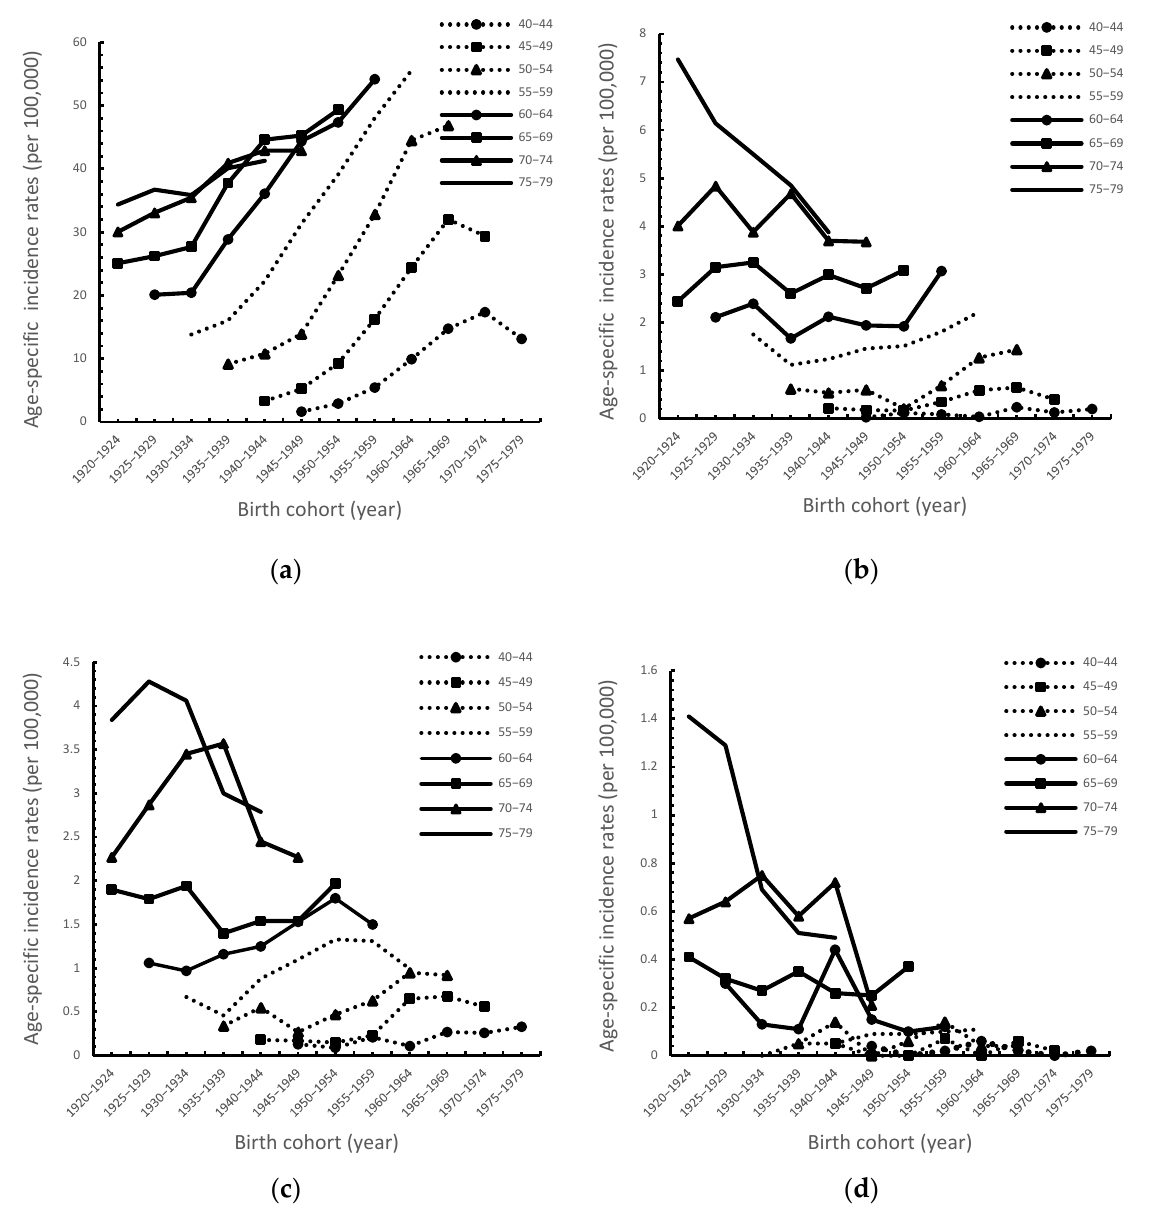
Figure 3. Age-specific incidence rates of esophageal squamous cell carcinoma (ESCC) and adenocarcinoma (EAC) in Taiwan by sex and birth cohort for the period 1920–1979. ( a ) ESCC in men; ( b ) ESCC in women; ( c ) EAC in men; ( d ) EAC in women.